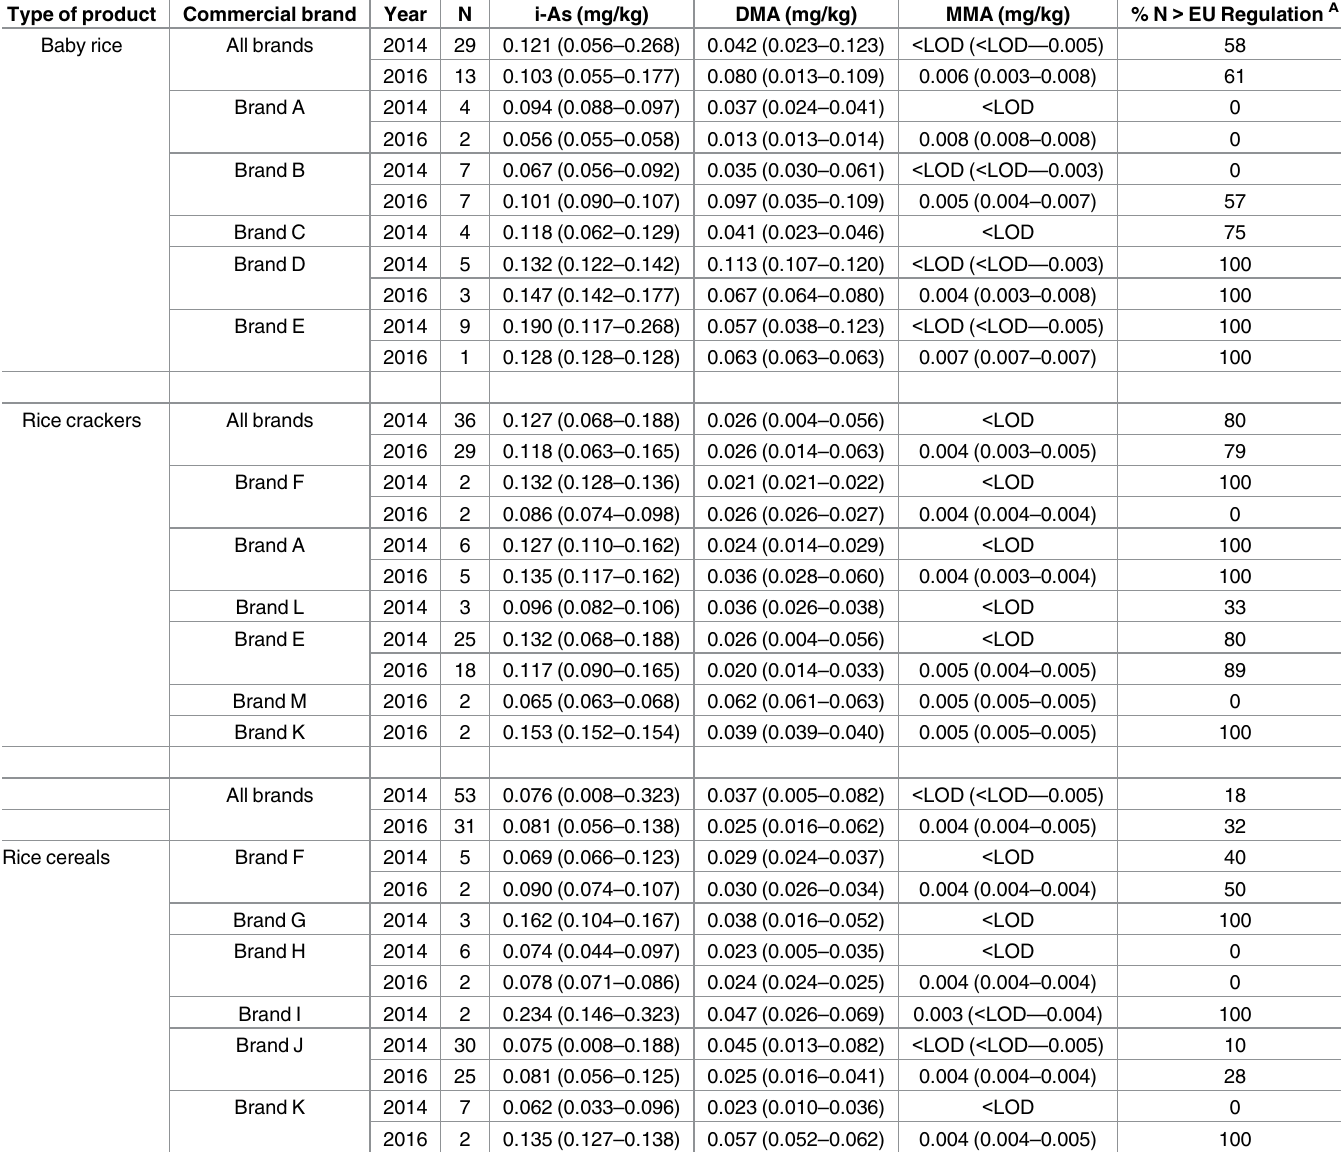
Table 3. Concentration of As speciation (mg/kg) (median (min—max)) in rice-based products specifically marketed(baby rice and rice crackers) or consumed (rice cereals)by infants and young children ordered by type of product, commercialbrand and year of collection. Type of